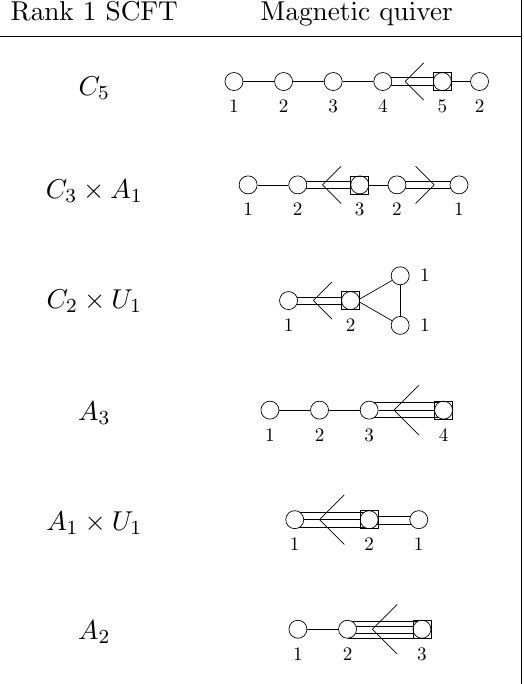
= 2 rank 1 theories with enhanced Coulomb branches N